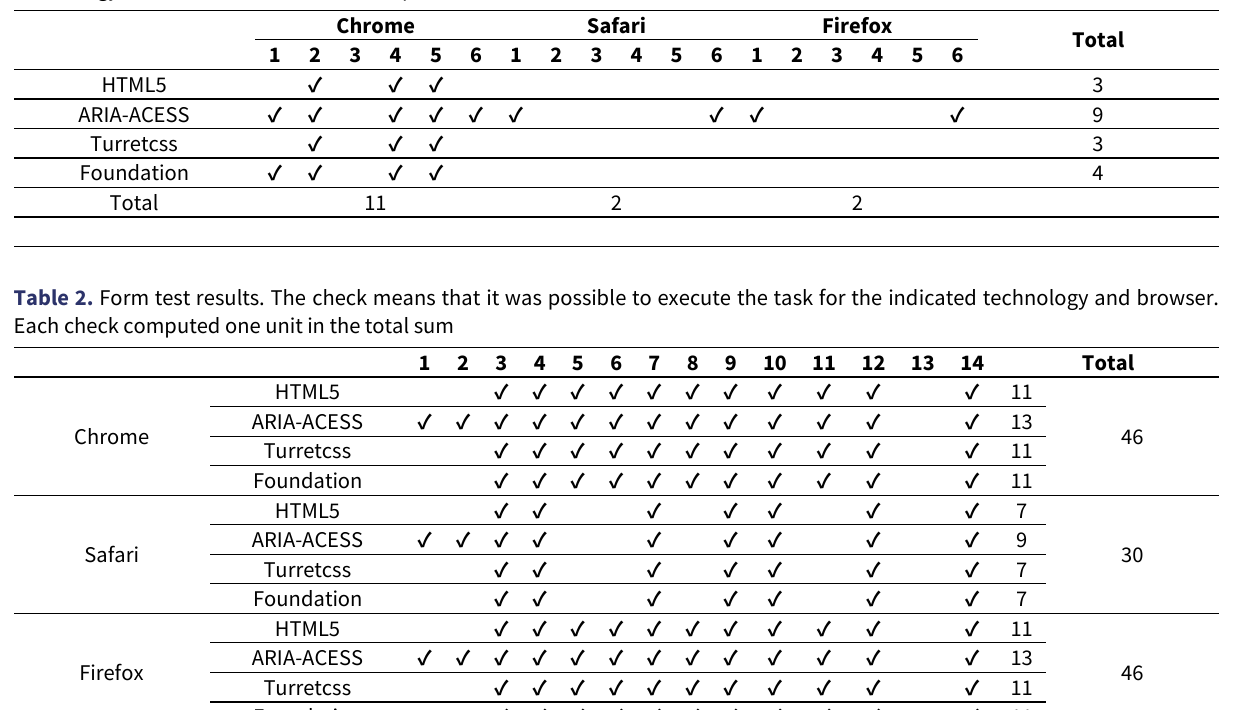
Table 1. Results for the navigation menu test. The check means that it was possible to execute the task for the indicated technology and browser. Each check computed one unit in the total sum